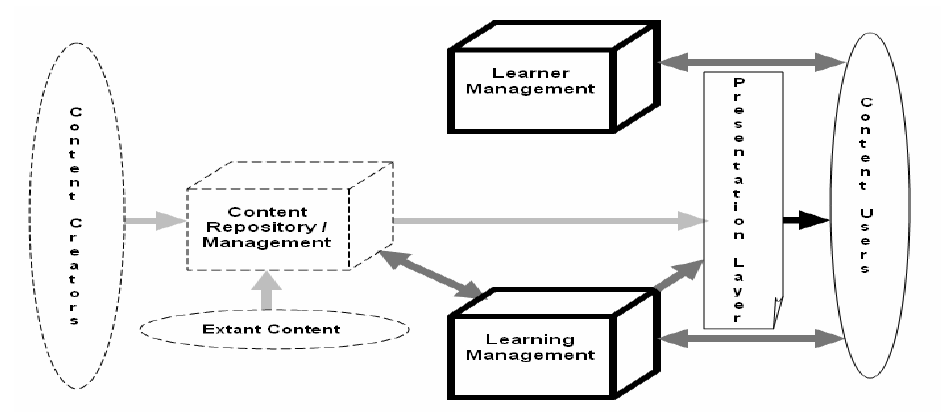
Figure 1 . LMS Components ( Irlbeck & Mowat, 2005, p.